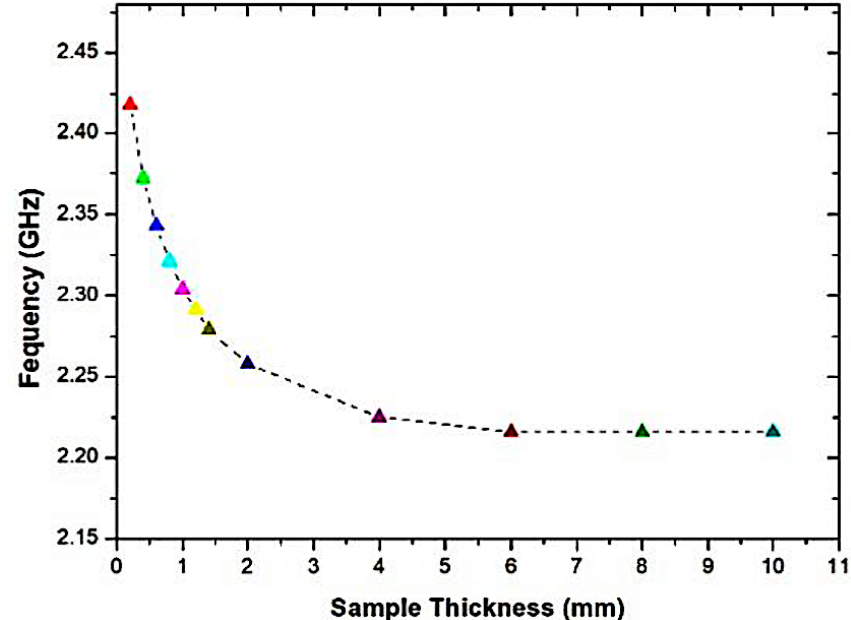
Figure 9. Relationship of the frequency band with a sample thickness of (h) mm .